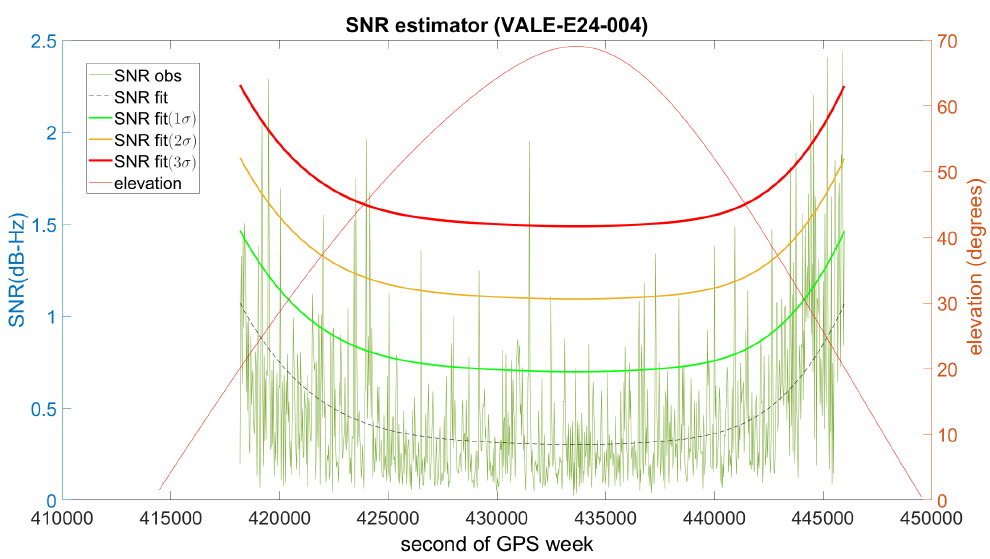
Figure 4. Low-multipath function used as reference to compute the SNR estimator for Galileo